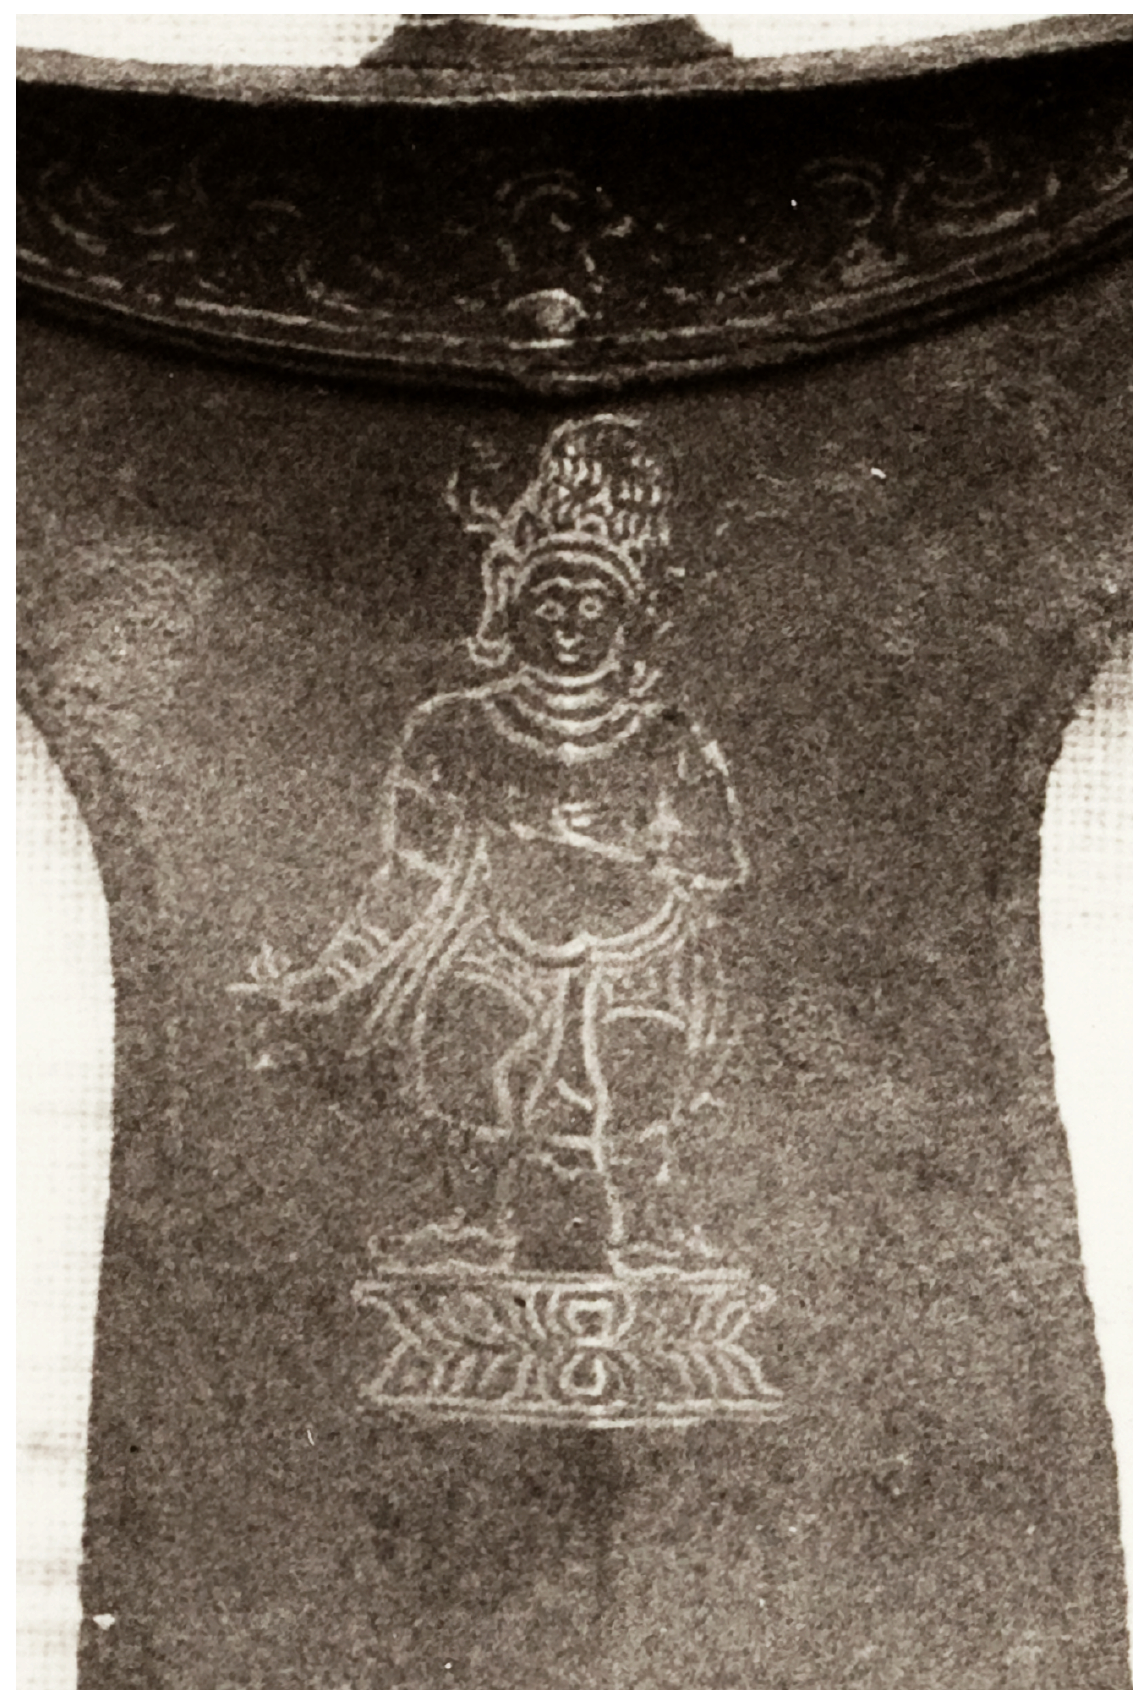
Figure 1 Male figure depicted on the Mandākinī sword (detail). Minangkabau regalia collection, Pagar Ruyung, West Sumatra. Licence: CC BY 4.0. Source: Leiden University shelfmark KITLV 163330